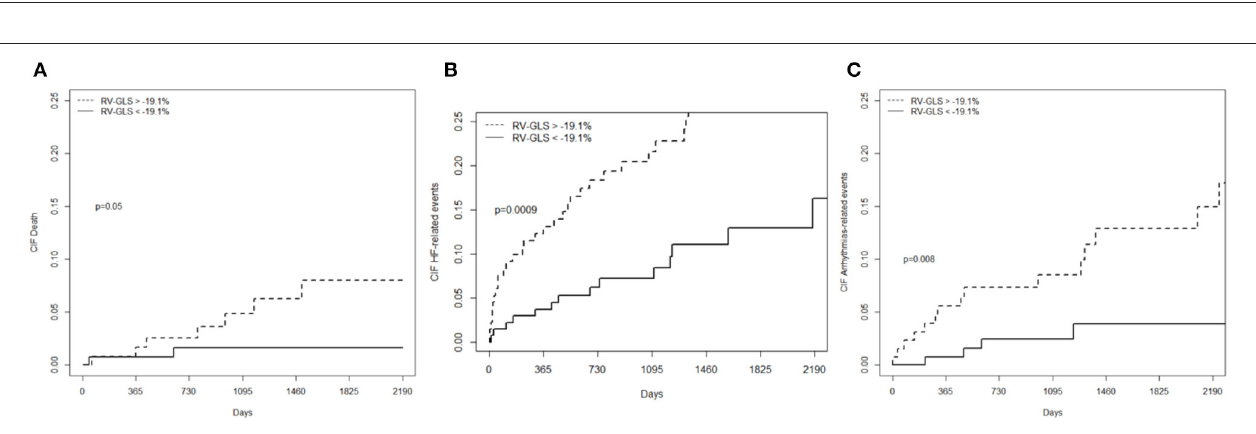
FIGURE 5 | Cumulative incidence curves showing the significant association between RV-GLS and secondary endpoints: (A) overall cardiovascular mortality; (B) HF-related events (HF death/heart transplant/destination therapy VAD implantation, hospitalization for HF); (C) Life threatening arrhythmia-related events (sudden cardiac death or life-threatening ventricular arrhythmias including ICD appropriate intervention). RV-GLS confirms its ability to predict events also in secondary endpoints. CIF, cumulative incidence curves; MACEs, major cardiovascular events; RV-GLS, right ventricular global longitudinal